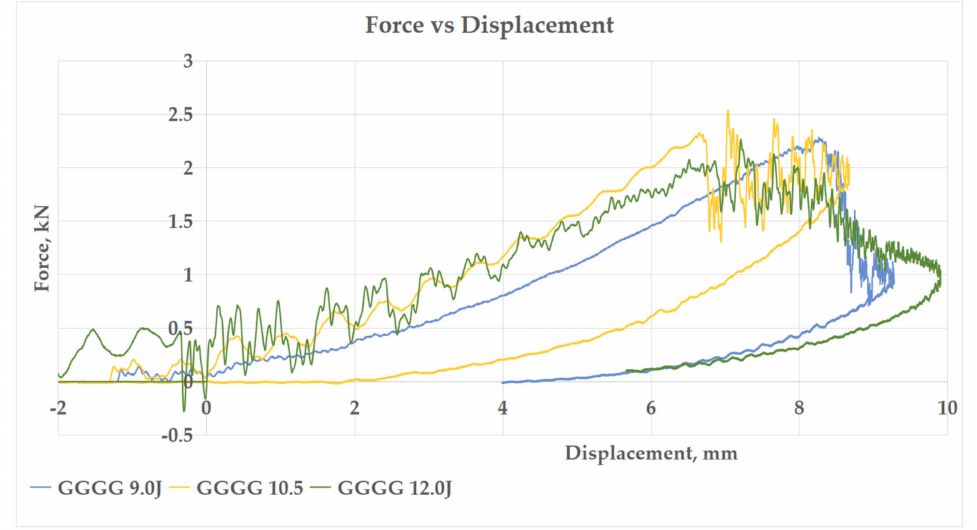
Figure 10. Force–Displacement curve of impact energy prior to GGGG perforation.